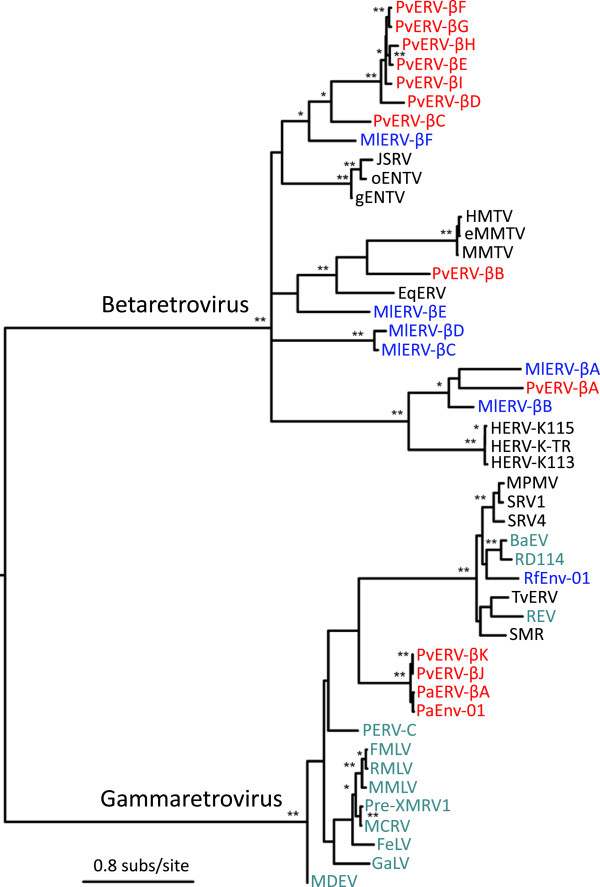
Phylogenetic comparison of the envelope (Env) protein sequence of betaretroviruses and gammaretroviruses. Bootstrap values <70% are not shown, and branch lengths are drawn to a scale of amino acid substitutions per site. Bootstrap values are denoted as ** >90%; * >70% and <90%. βERV proteins of P. vampyrus and P. alecto are highlighted in red text. βERVs of M. lucifugus and R. ferrumequinum are highlighted in blue text. Gammaretroviruses are highlighted in teal text.